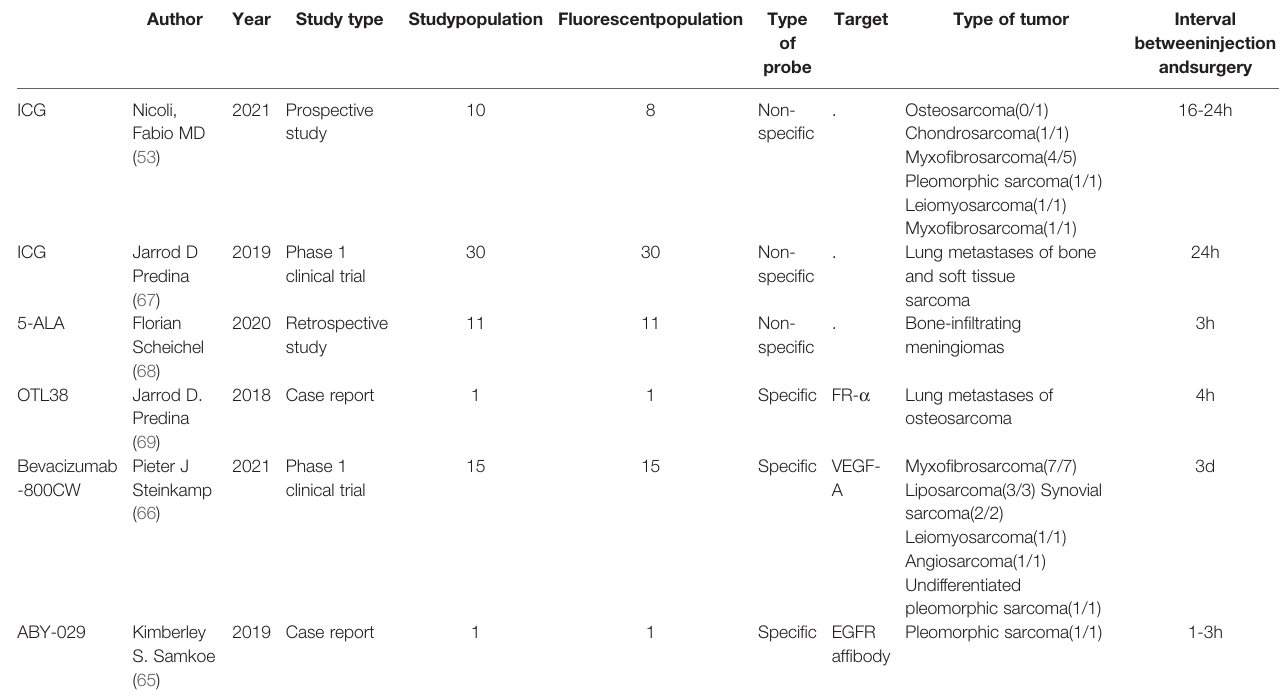
TABLE 2 | Clinical Trials in fl uorescence imaging for bone and soft tissue sarcoma